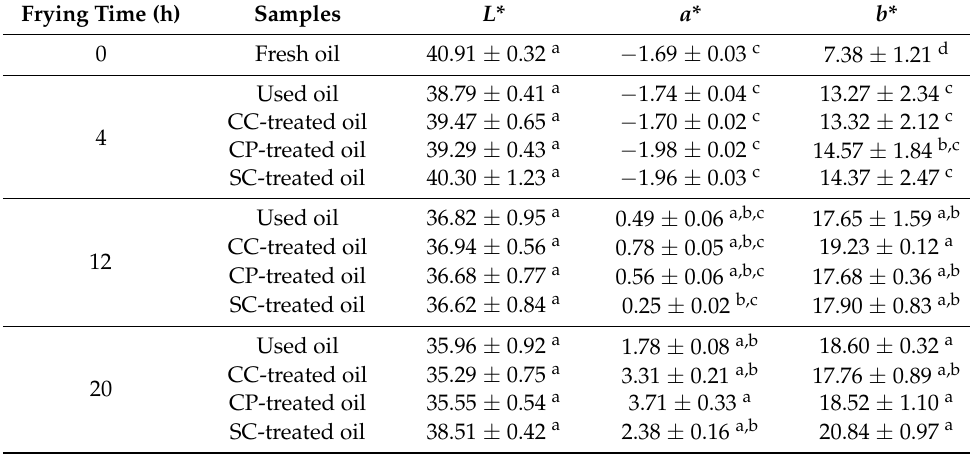
Table 8. Color analysis ( L *, a *, and b * values) of fresh, used and treated oils with different lignocellu- losic biomasses; including corn cob (CC), cornstalk piths (CP), and sugarcane bagasse (SC); 4, 12, and 20 means the frying period by (h, hours). Means with different letters ( a , b , c , d ) within each column indicate statistically significant differences between the samples after Duncan’s analysis ( p < 0.05). Frying Time (h) Samples L * a *